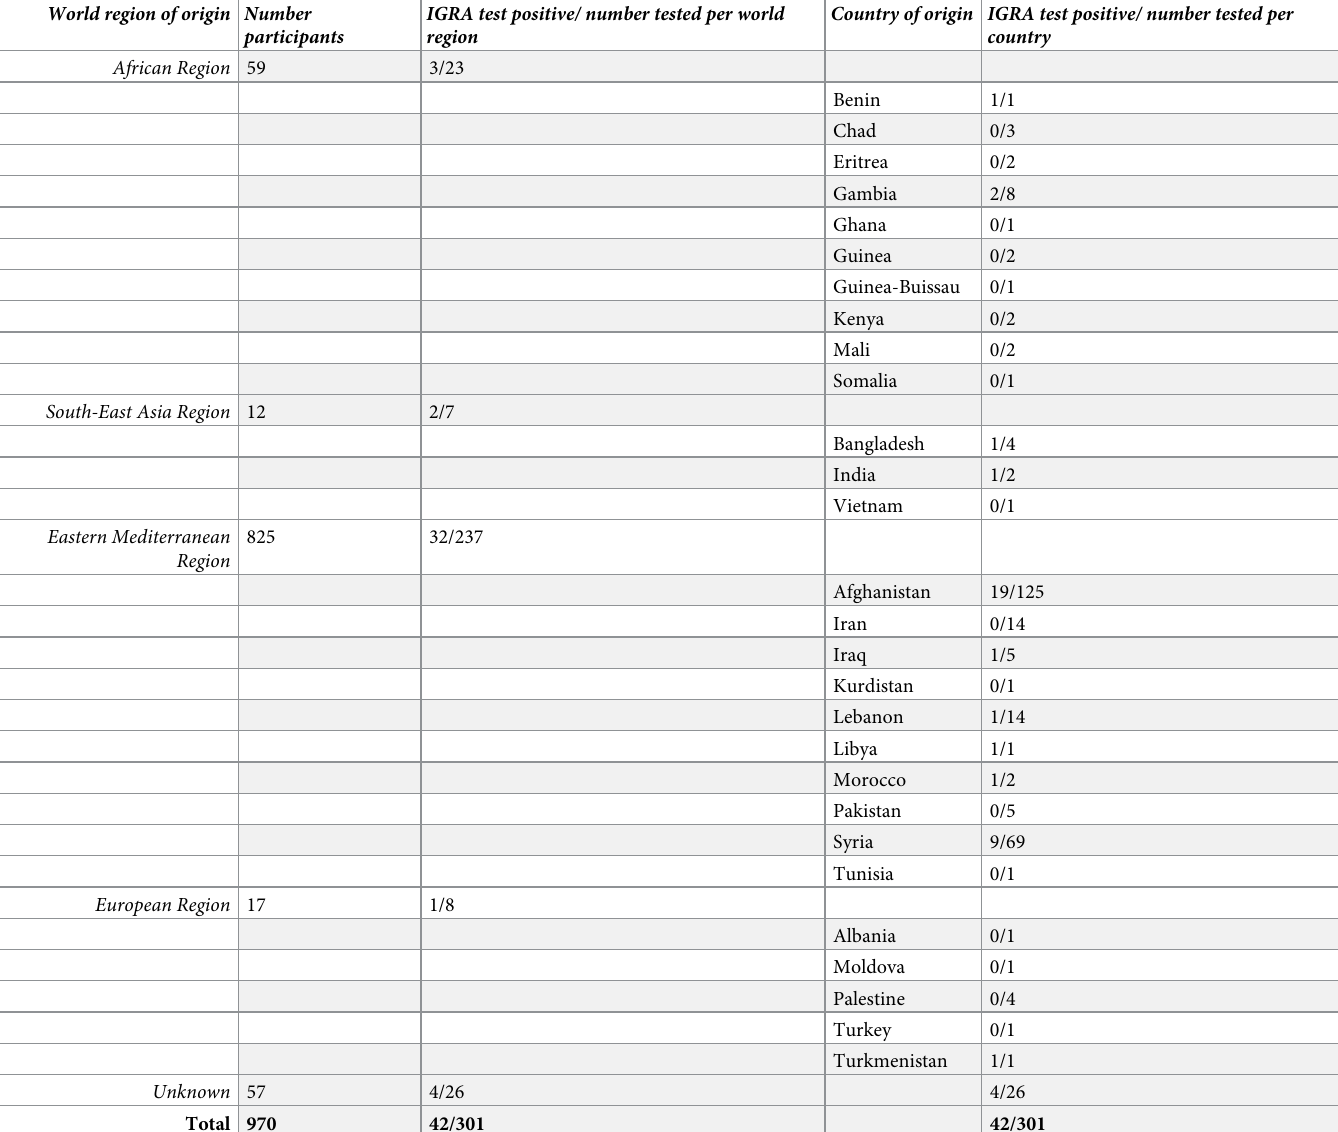
Table 1. Country of origin of participants according to WHO world regions[37], number of participants receiving interferon- γ -release-assay (IGRA) -testing (n = 301) and numbers of positive (IGRA) test results (n = 42) according to country of origin. World region of origin Number